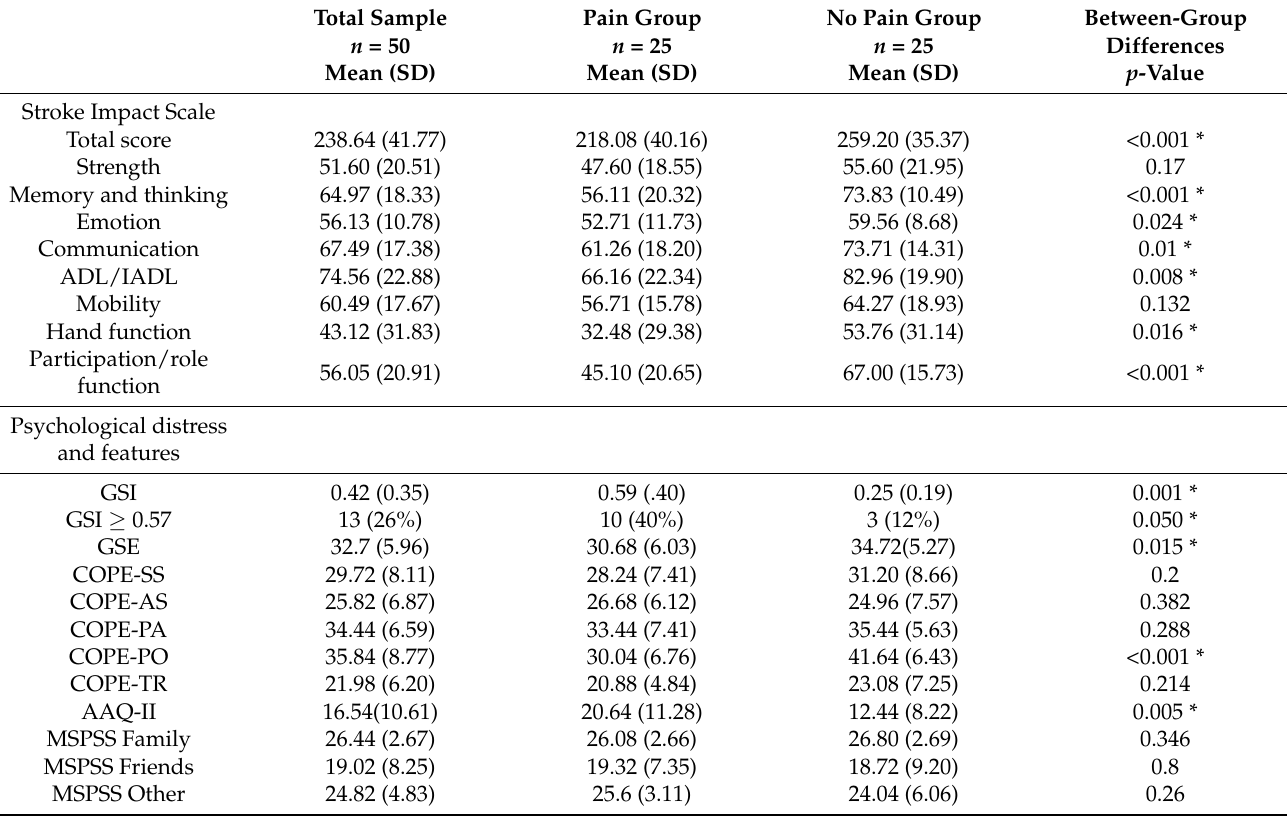
Table 3. Stroke Impact Scale scores; Disability and health-related quality of